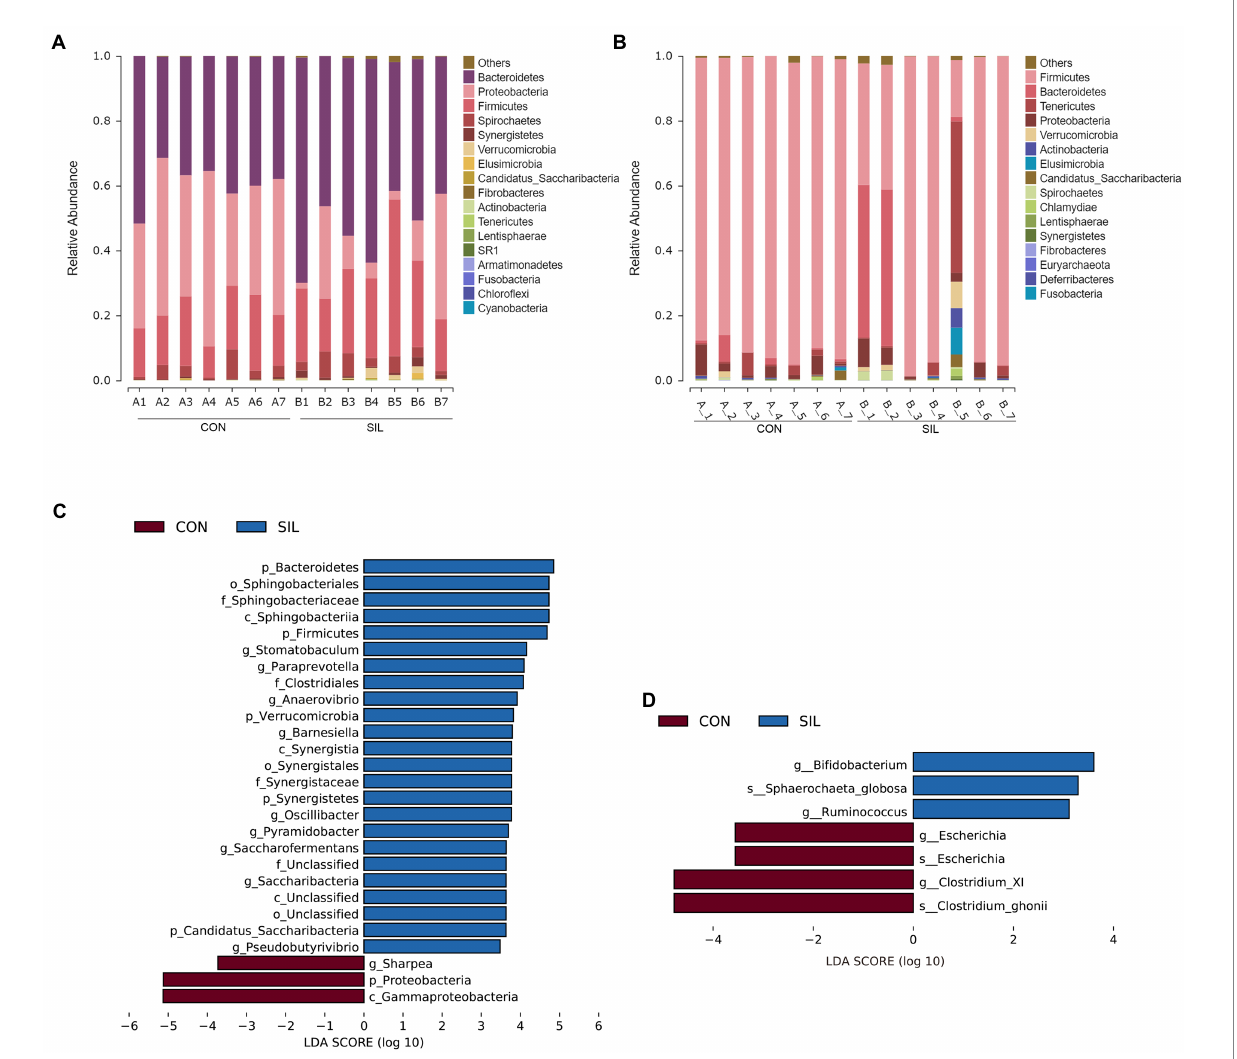
FIGURE 3 Taxonomic analysis of the microbial communities in the rumen and ileum digesta samples of lambs in the CON and SIL groups. The relative abundance of microbial composition at the phylum level in the rumen (A) and ileum (B) ; Linear discriminant analysis (LDA) effect size linear discriminant analysis (LEfSe) of the rumen (C) and ileum (D) CON = supplemented with 10% soybean meal; SIL = supplemented with 10% silybum marianum